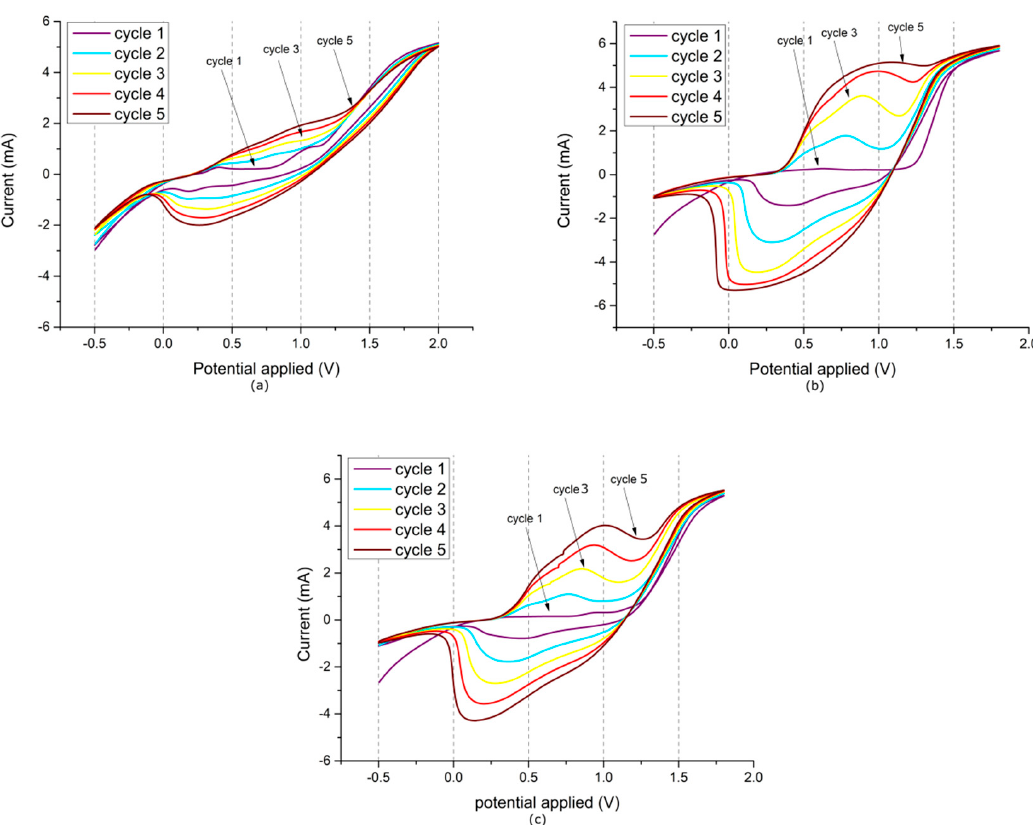
Figure A4. Electrochemical polymerisation of In-HT ( a ), Cz-HT ( b ), Fl-HT ( c ) containing 10 vol % boron trifluoride diethyl etherate.